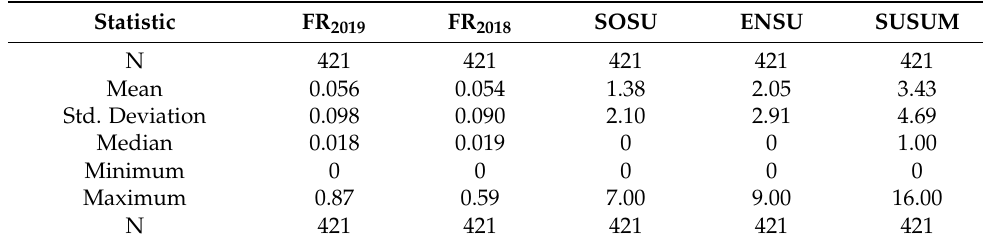
Table 4. Descriptive statistics of independent and dependent